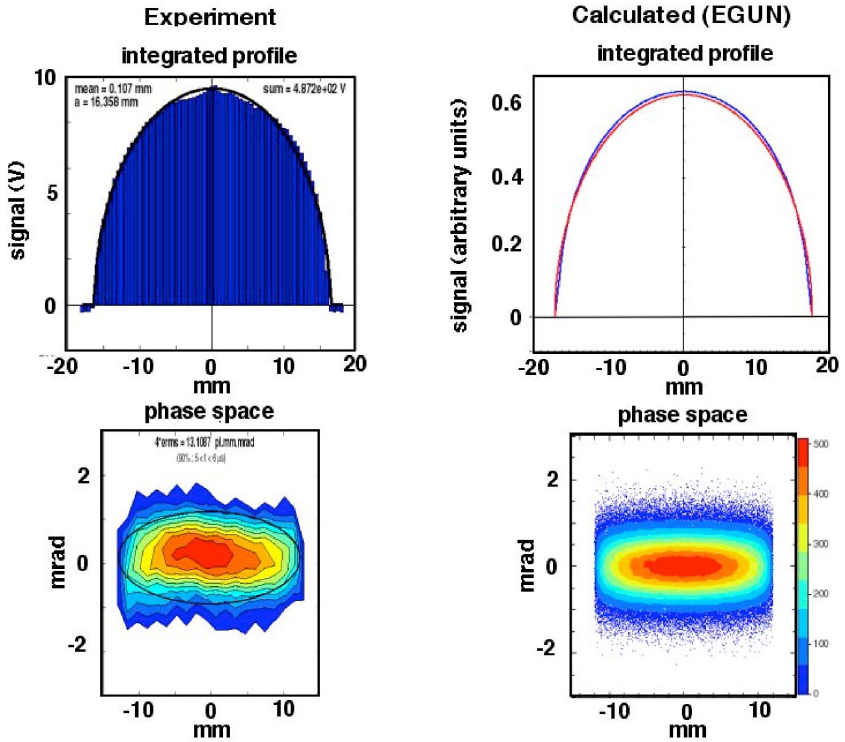
FIG. 12. (Color) Slit-integrated density profile and ( x; x 0 ) phase space of a high-brightness apertured beam (300 kV, 25 mA, 2-cm aperture). The corresponding EGUN calculations are shown to the